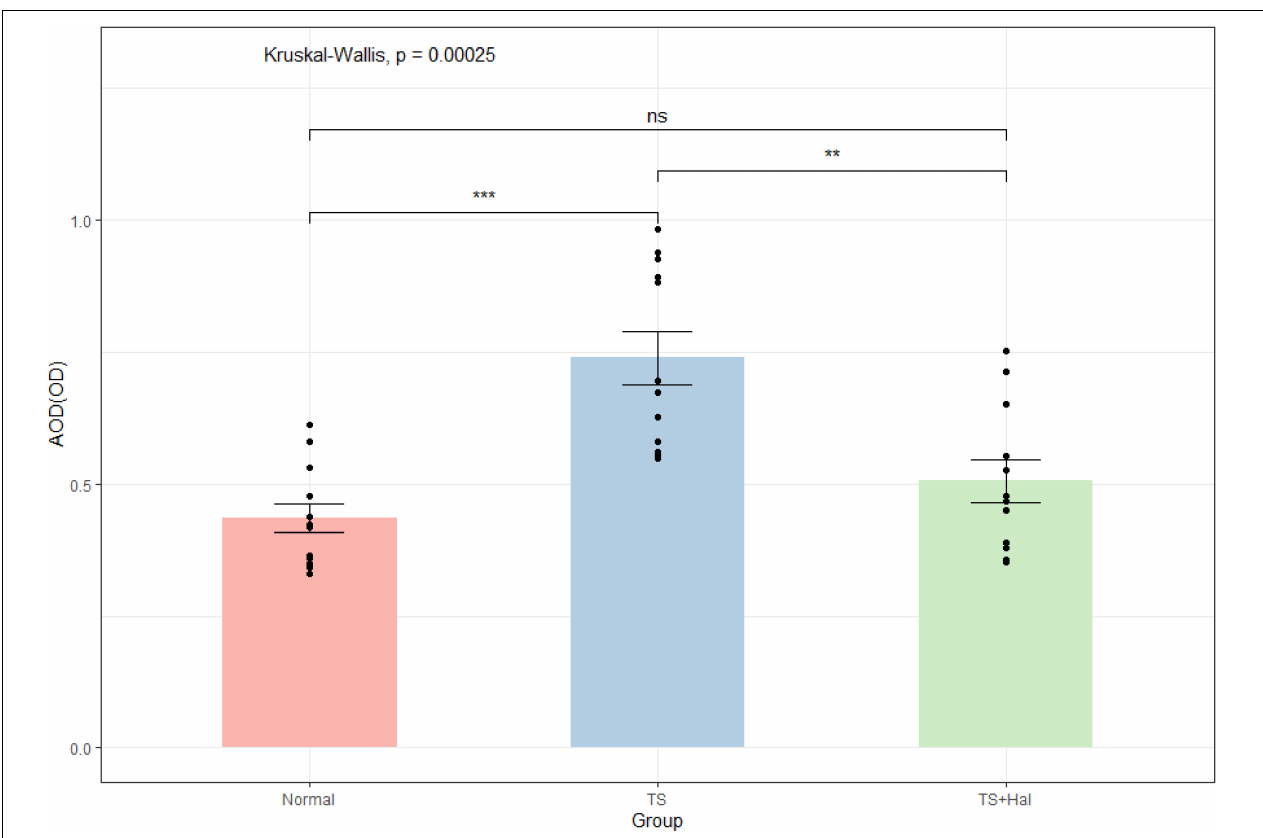
FIGURE 3 | The comparison of activated microglia (AOD) in the brain of each group. TS, Tourette syndrome; TS + Hal, TS + haloperidol; ns, not significant; (cid:70) (cid:70) (cid:70) : P < 0.001; (cid:70) (cid:70) : P < 0.01.